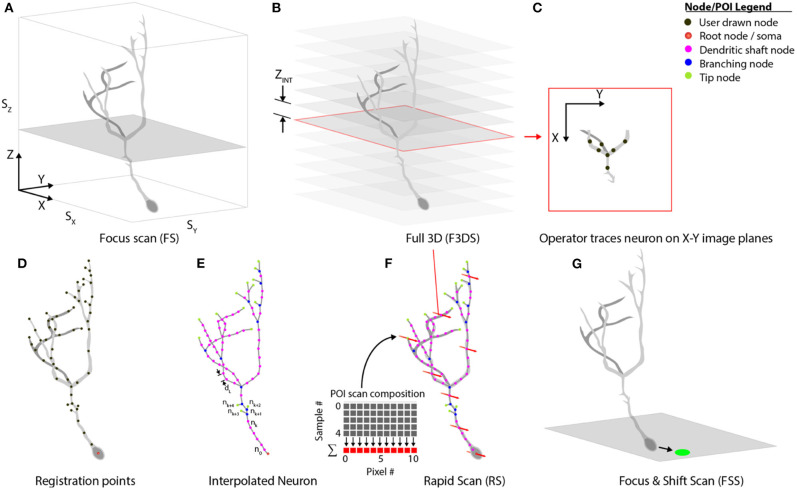
Scan class hierarchy and scan types. (A) The focus scan (FS) allows the operator to adjust the position of the neuron in 3D-space, and defines the boundaries during scanning. (B) The Full 3D scan (F3DS) images the volume defined in the FS at an interval along the Z-axis, ZINT, which is defined by the operator. (C) After the F3DS is acquired, the operator traces the neuron on each X-Y image planes forming a (D) skeletonized frame of the neuron in 3D space. (E) The registration points, drawn by the operator, are then linearly interpolated over the entire arbor using a spatial separation distance of dL. (F) The POIs are scheduled for scanning and the volume rapid scan (V-RS) is executed scanning all interpolated POIs at calcium imaging rates. (G) Following the RS, the user has an opportunity to make adjustments to the position of the neuron in 3D space to account for minor position shifts.